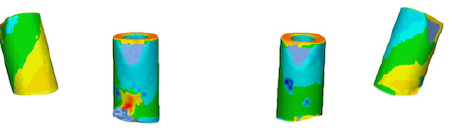
Figure 5. Colorimetric map showing the 3D deviation of intraoral scan bodies of an STL file obtained from digital intraoral scanning group.